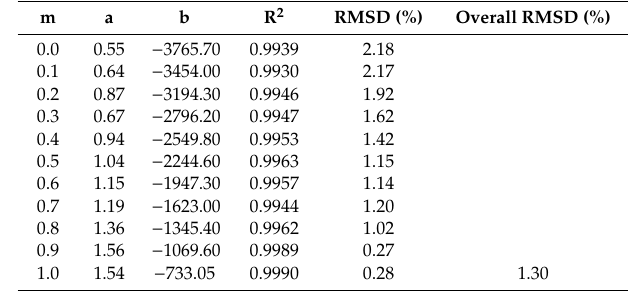
Table 4. The van’t Ho ff model parameters ( a and b ), R 2 and RMSD values for PPD in binary DMSO + water mixtures c